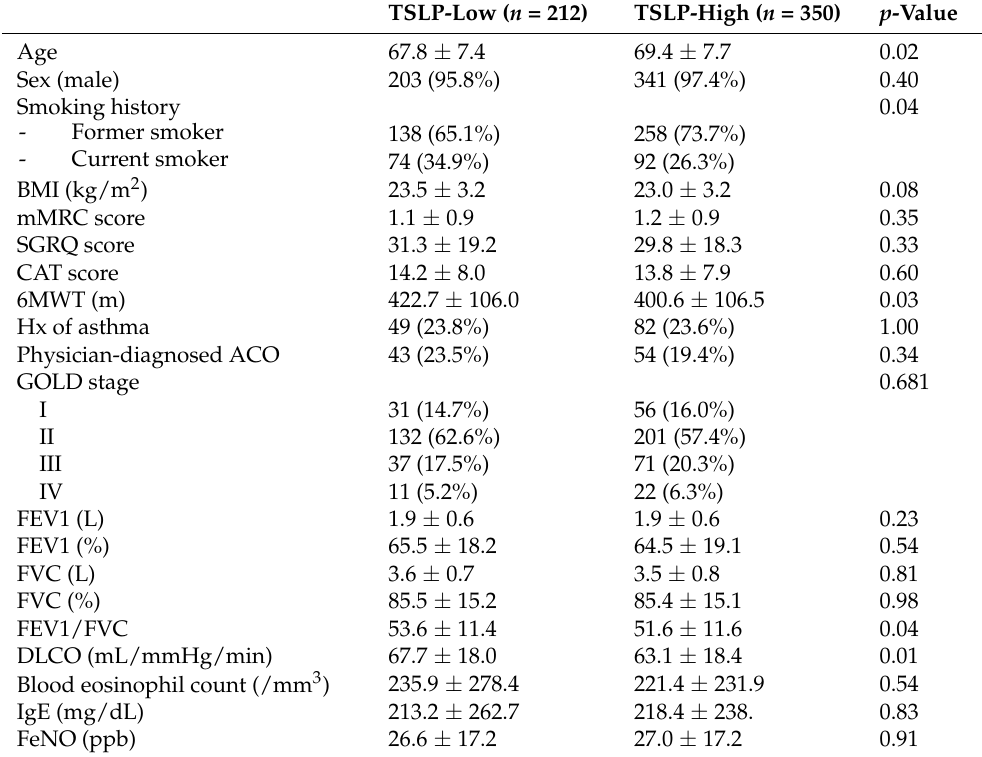
Table 3. Differences in clinical characteristics between TSLP-low/high